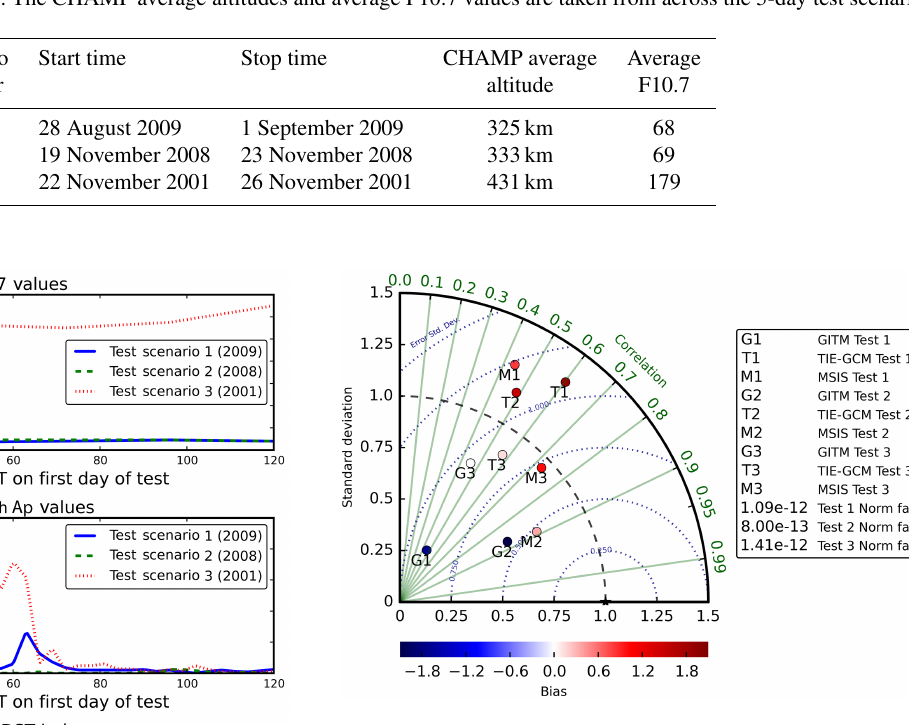
Figure 2. Modified Taylor diagram (Elvidge et al., 2014) for NRLMSISE-00 (MSIS), TIE-GCM, and GITM for neutral density, compared with CHAMP for each of the three test scenarios. The az- imuthal angle represents the correlation of the models neutral den- sity time series with the CHAMP observation. The radial distance shows the standard deviation of the model time series and the semi- circles, centred at a standard deviation of 1, is the standard deviation of the errors (model minus observation). The colour scale shows the bias (mean of model minus mean of truth). Each quantity is normal- ized and the original values can be reformed using the correspond- ing “factor” in the top right of the